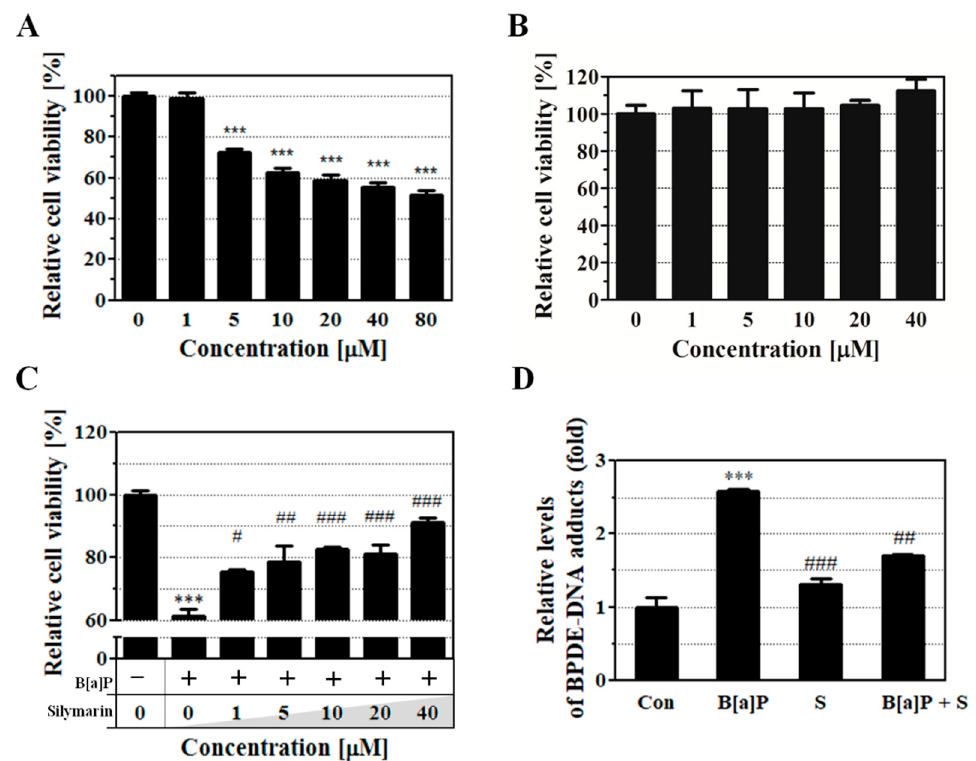
Figure 1. HepG2 cell viability was evaluated by cell viability assay. ( A , B ) HepG2 cells were treated with benzo[a]pyrene (B[a]P) or silymarin at various concentrations for 48 h. ( C ) B[a]P-induced cytotoxicity was reduced in cells treated with various concentrations of silymarin for 48 h. ( D ) The inhibitory effect of silymarin on B[a]P-7,8-dihydrodiol-9,10-epoxide (BPDE)-DNA adduct formation was measured by enzyme-linked immunosorbent assay (ELISA). HepG2 cells were treated with B[a]P (10 μ M) in the presence or absence of silymarin (40 μ M) for 48 h. All treatment group values were significantly different in comparison to the controls (*** p < 0.001) and to B[a]P (# p < 0.05, ## p < 0.01, and ### p < 0.001) in Tukey’s multiple comparison test.